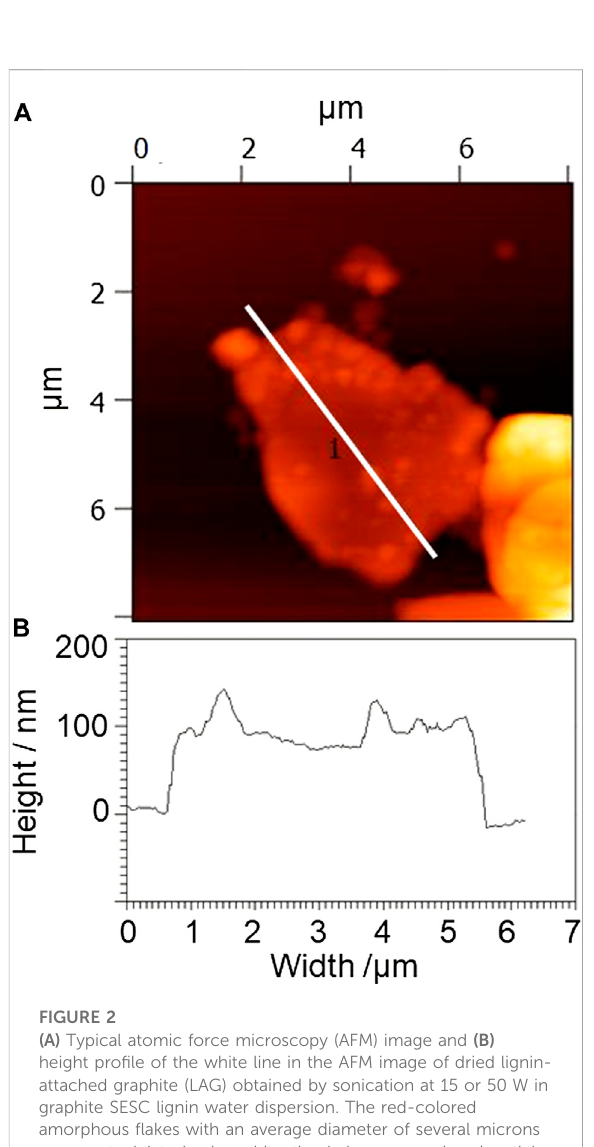
FIGURE 2 (A) Typical atomic force microscopy (AFM) image and (B) height pro fi le of the white line in the AFM image of dried lignin- attached graphite (LAG) obtained by sonication at 15 or 50 W in graphite SESC lignin water dispersion. The red-colored amorphous fl akes with an average diameter of several microns representminiaturizedgraphite;thedarkorange-coloredparticles on the fl akes with an average diameter of several tens of nanometers are SESC lignin attached to the graphite.